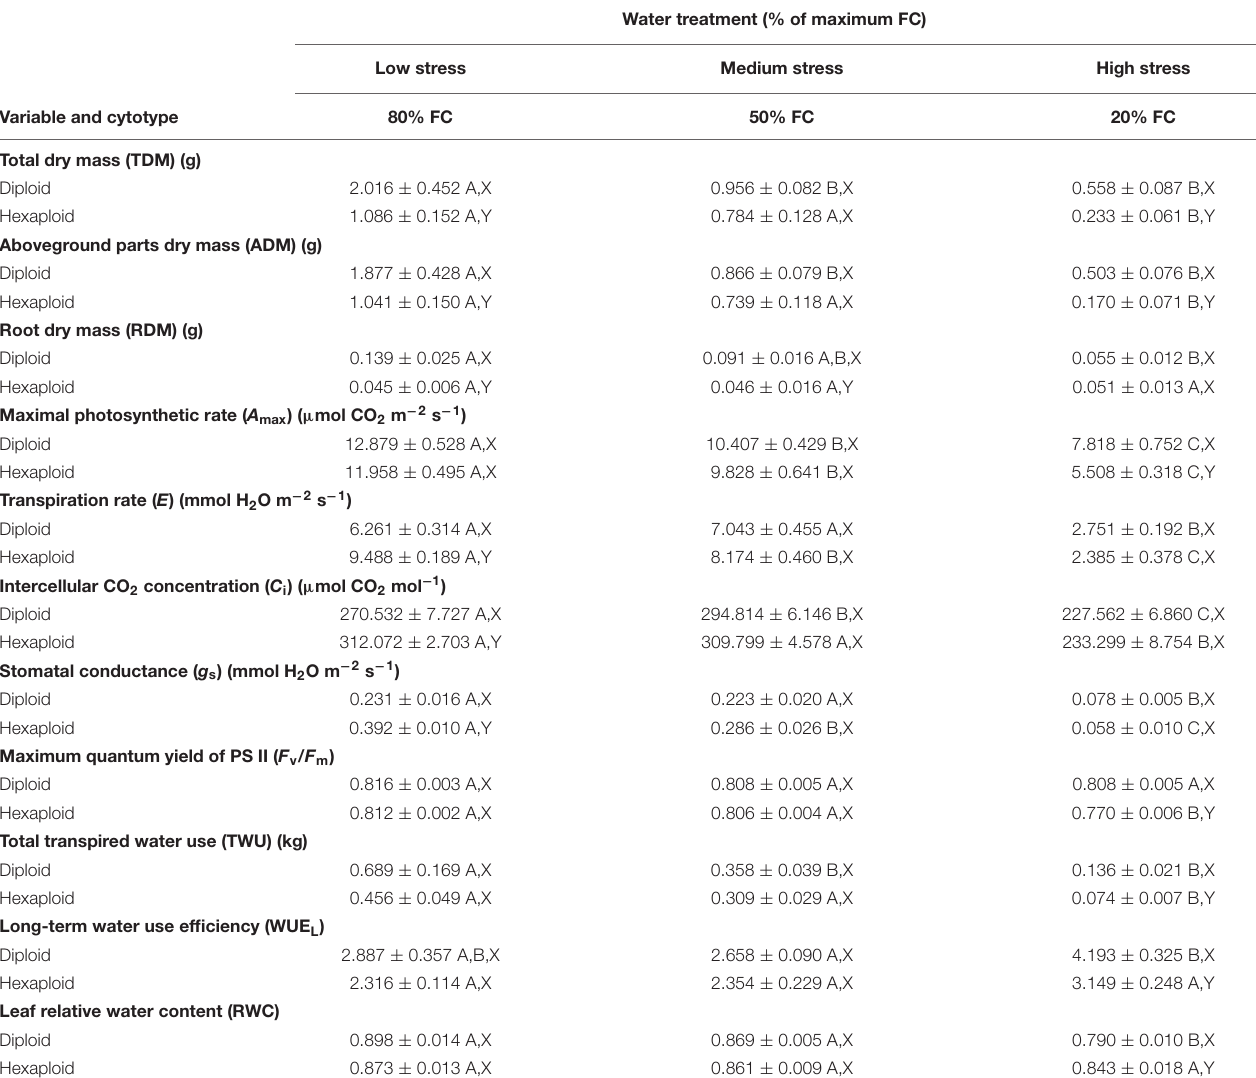
TABLE 1 | Comparison of 11 measured indicators between Chamerion angustifolium diploids and hexaploids, across three different soil water treatments (80% of maximal field capacity (FC), 50% FC, and 20% FC). Water treatment (% of maximum FC) Low